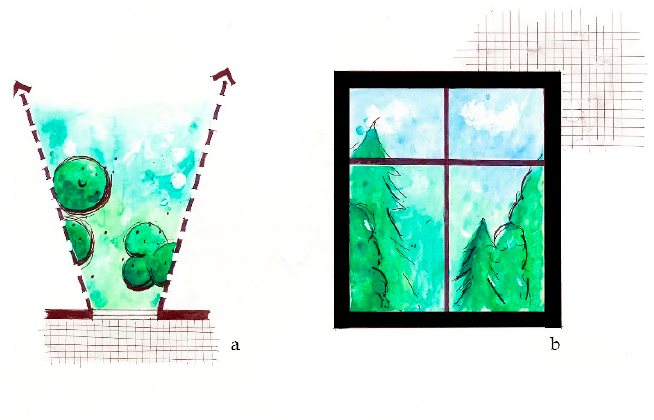
Figure 2. The View from within intervention considers green view opportunities for building occupants, such as trees, plants, water, or distant landforms, from the inside of a building. ( a ) Plan view sketch of window looking over landscape; ( b ) Sketch elevation of potential view from a window.